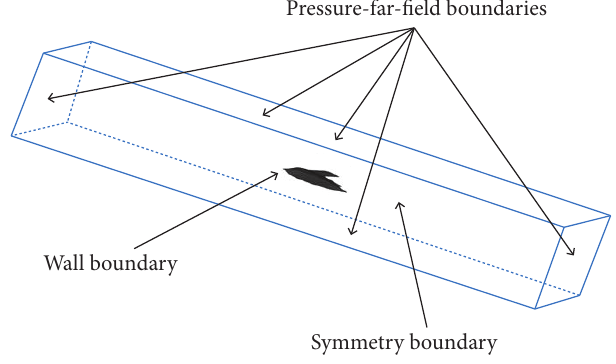
Figure 6. Calculation domain and boundary conditions.